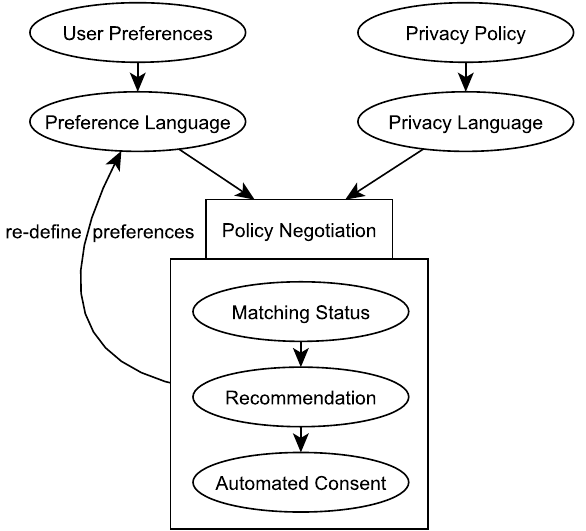
Figure 1. User preferences, expressed in preference languages, are matched against the privacy policies of Controllers , which are expressed in privacy languages. Matching status, consent recom- mendation or automated consent are used to ease policy